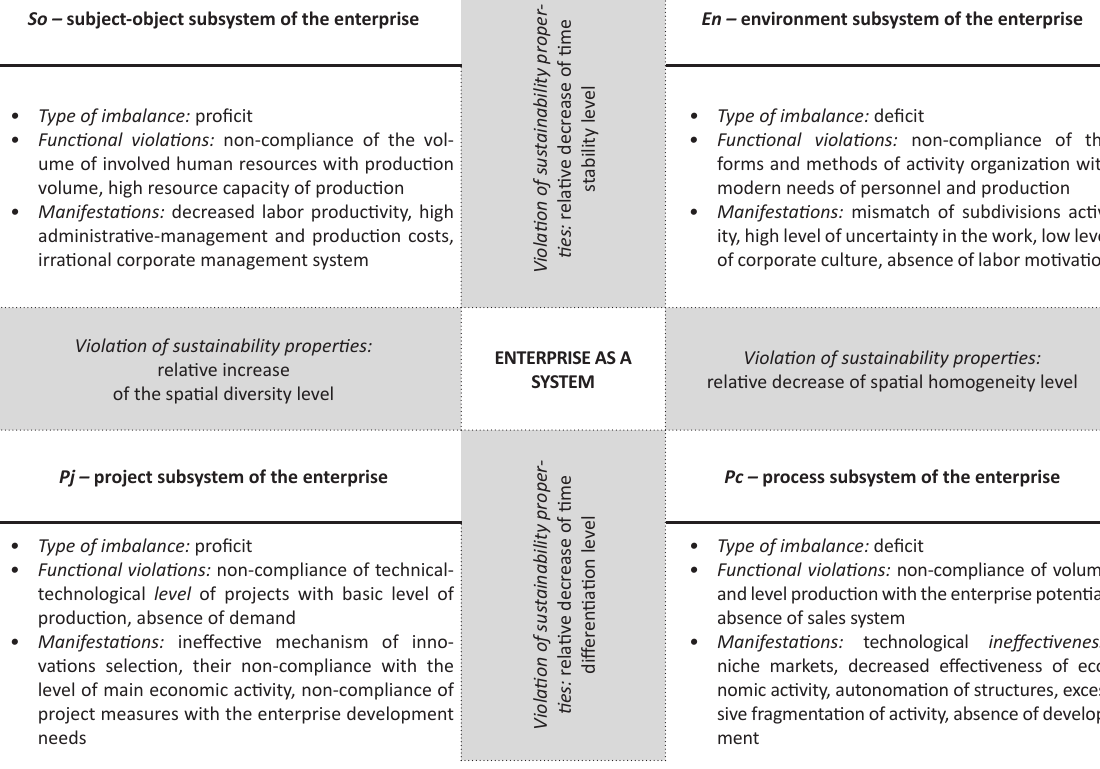
Figure 5. Generalized characteristic of the defined structural peculiarities of